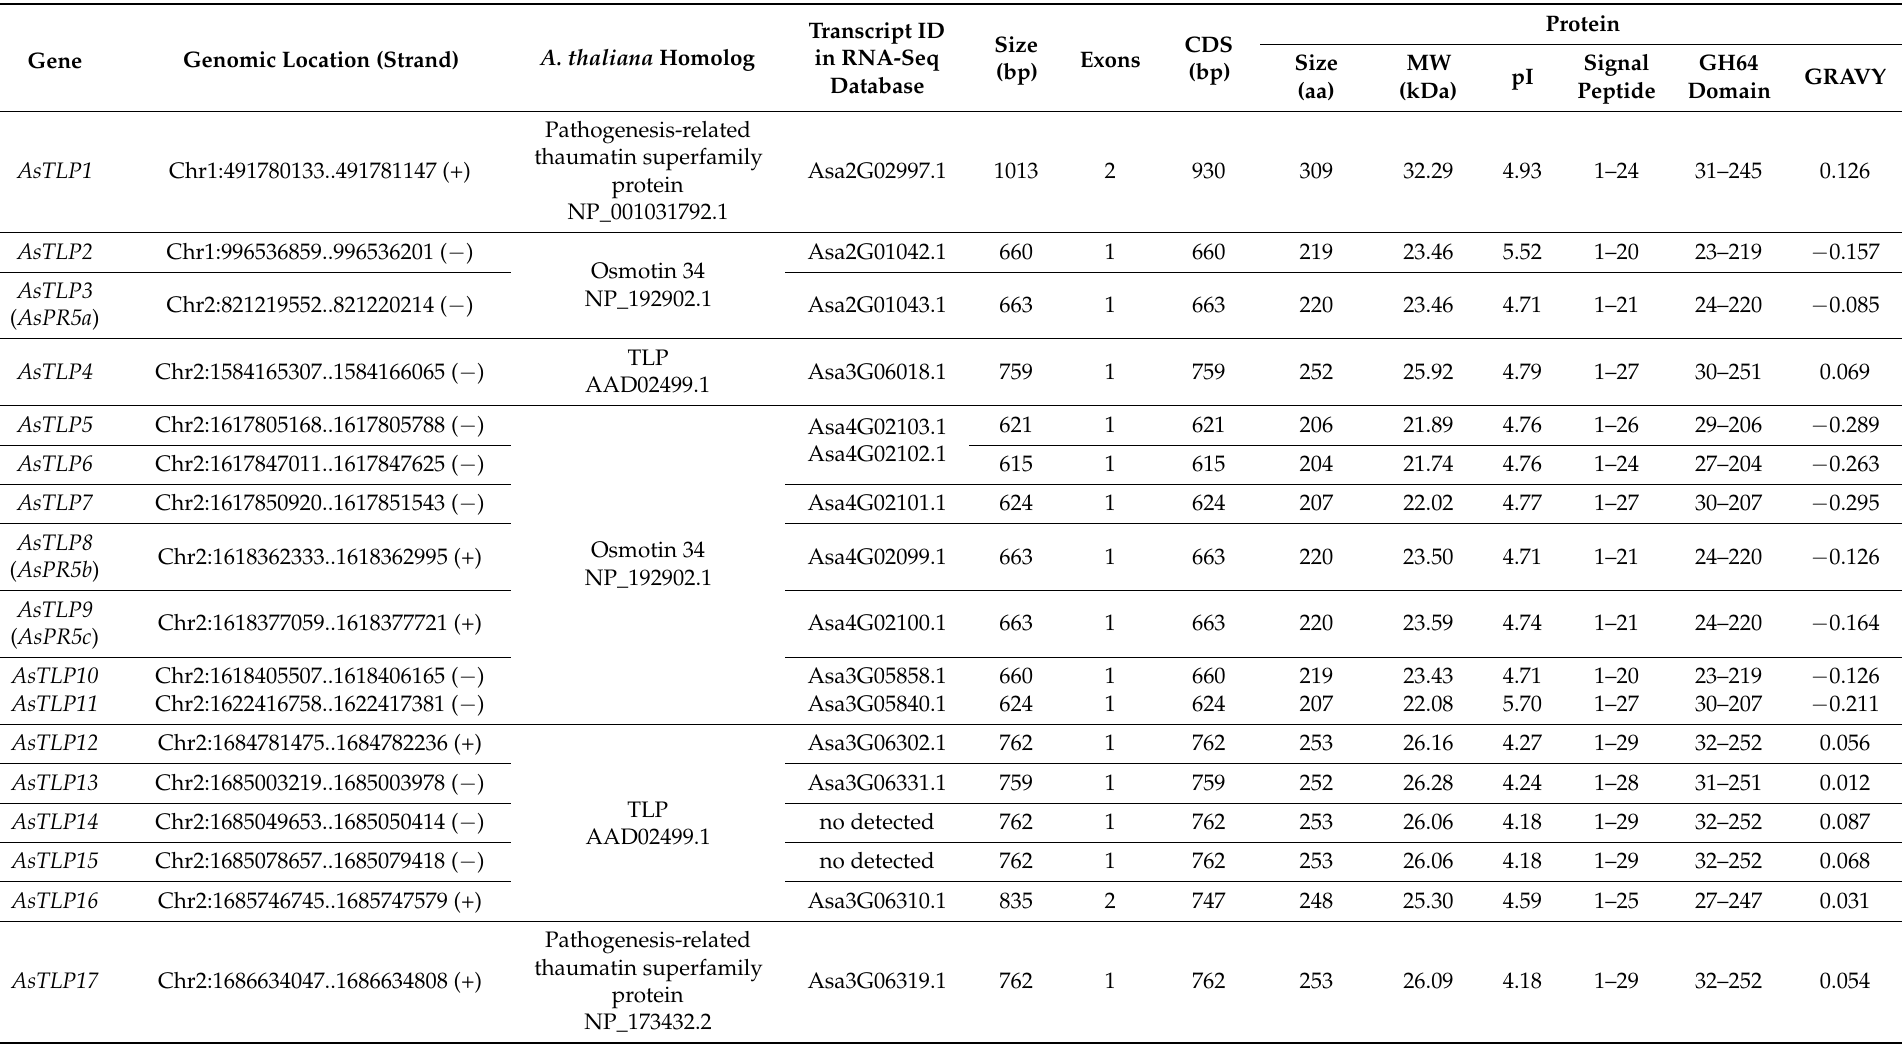
Table 1. Characteristics of the predicted TLP genes in the A. sativum cv. Ershuizao